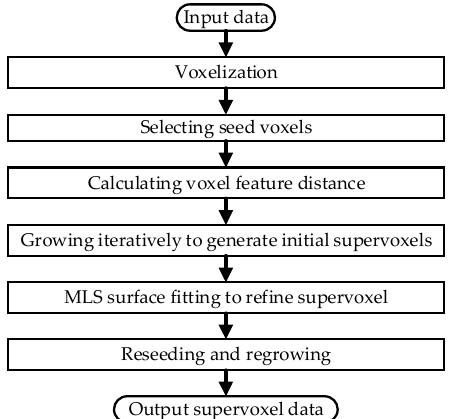
Figure 5. The process of an improved over-segmentation approach based on supervoxels and MLS surface fitting. surface